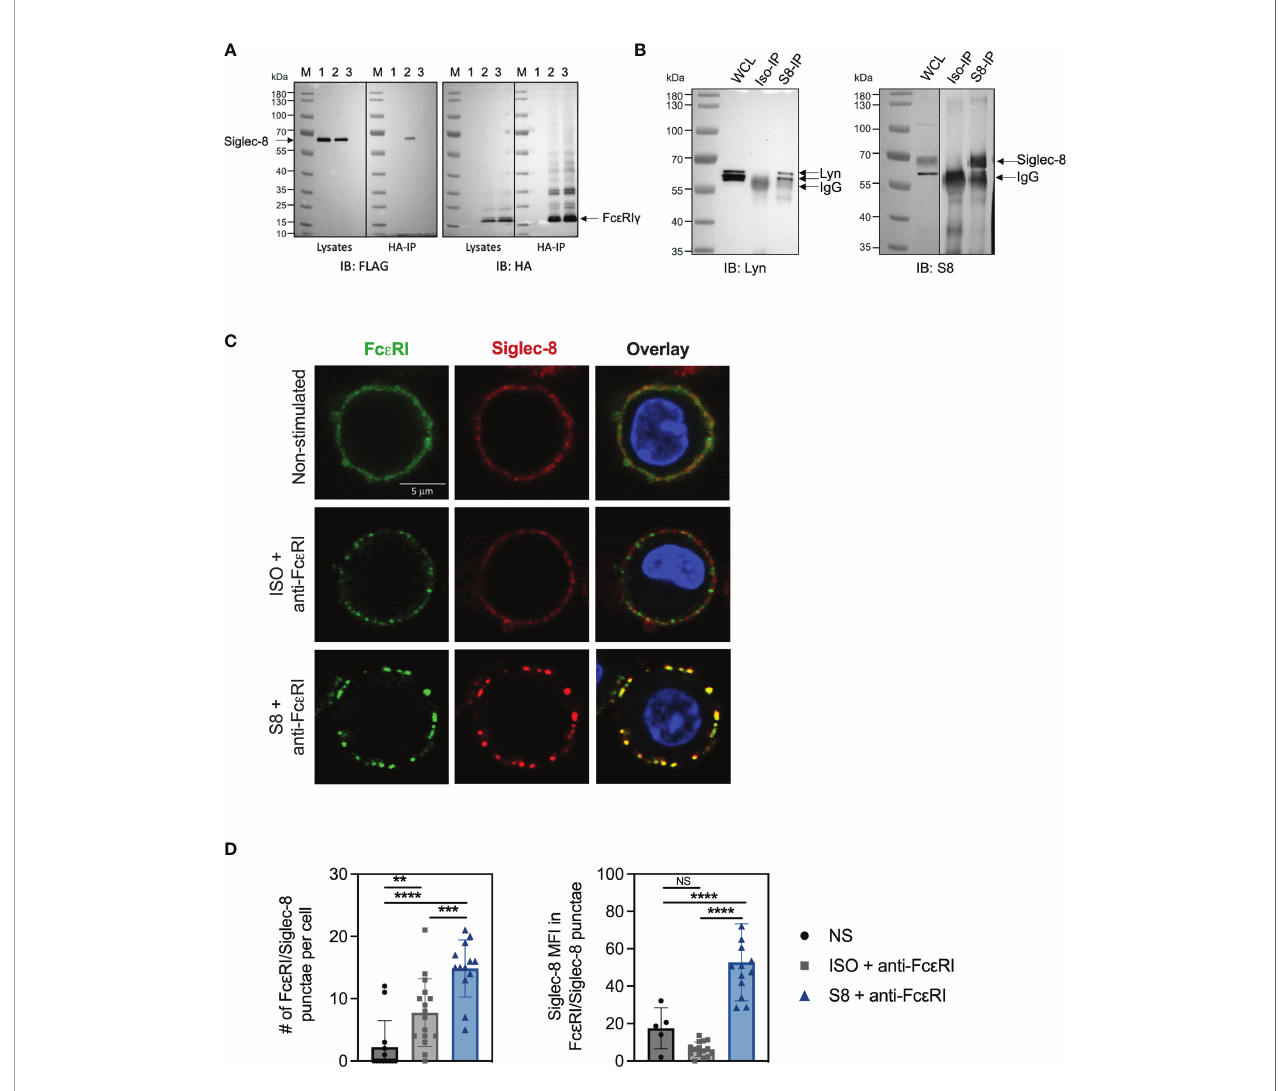
FIGURE 4 | Siglec-8 interacts with Fc e RI machinery components. (A) Western blot analysis of Siglec-8-Fc e RI g interaction. Immunoblot (IB) of whole cell lysates (WCL) or HA immunoprecipitations (IP) from primary MC transfected with expression constructs for Siglec-8-FLAG (lane 1) or Fc e RI g -HA (lane 3) or both (lane 2). Blots were developed with anti-FLAG (left panel) and anti-HA (right panel). (B) Western blot analysis of Siglec-8-Lyn interaction. WCL, isotype IP or S8 IP from S8-BMMC were developed using anti-Lyn or anti-Siglec-8 antibodies. (C) Confocal microscopy imaging of Siglec-8 (red) and Fc e RI (green) in S8-BMMC. (D) Quanti fi cation of confocal images. Left panel: number of Fc e RI punctae per cell (PE channel). Right panel: Siglec-8 median fl uorescence intensity within Fc e RI/ Siglec-8 punctae (AF647 channel). Experiments were performed 2-3 times. NS, not signi fi cant, **p < 0.01, ***p < 0.001, ****p < 0.0001 by one-way ANOVA